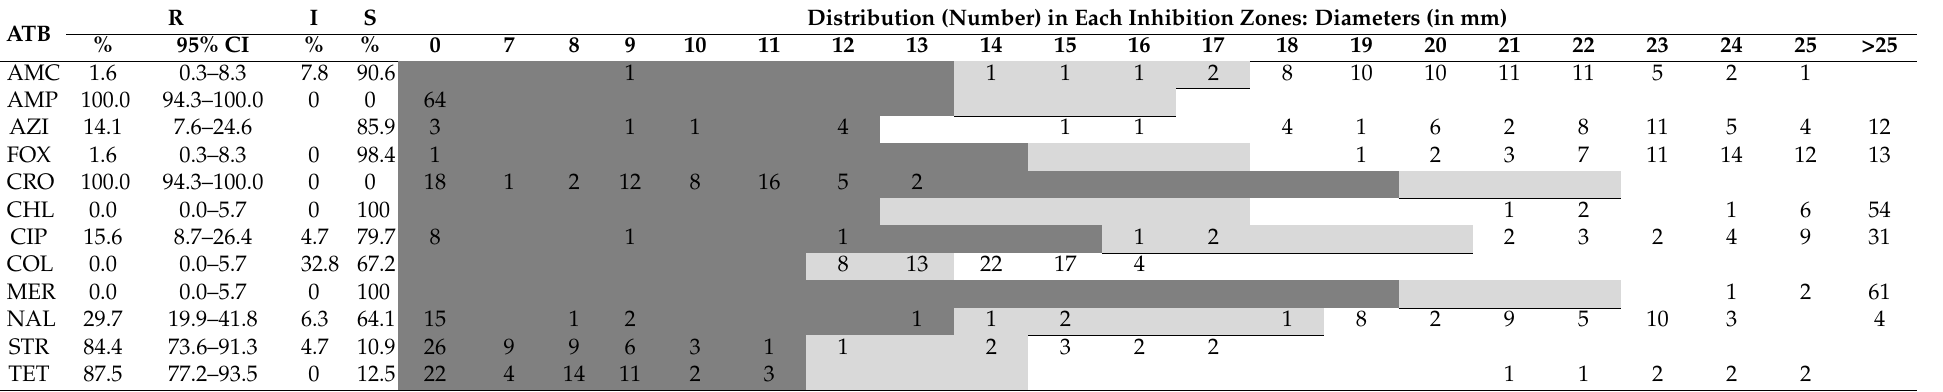
Table 3. Susceptibility to antibiotics of E. coli resistant to third-generation cephalosporins ( n = 64) from food animals in the East province of Rwanda. Distribution (Number) in Each Inhibition Zones: Diameters (in